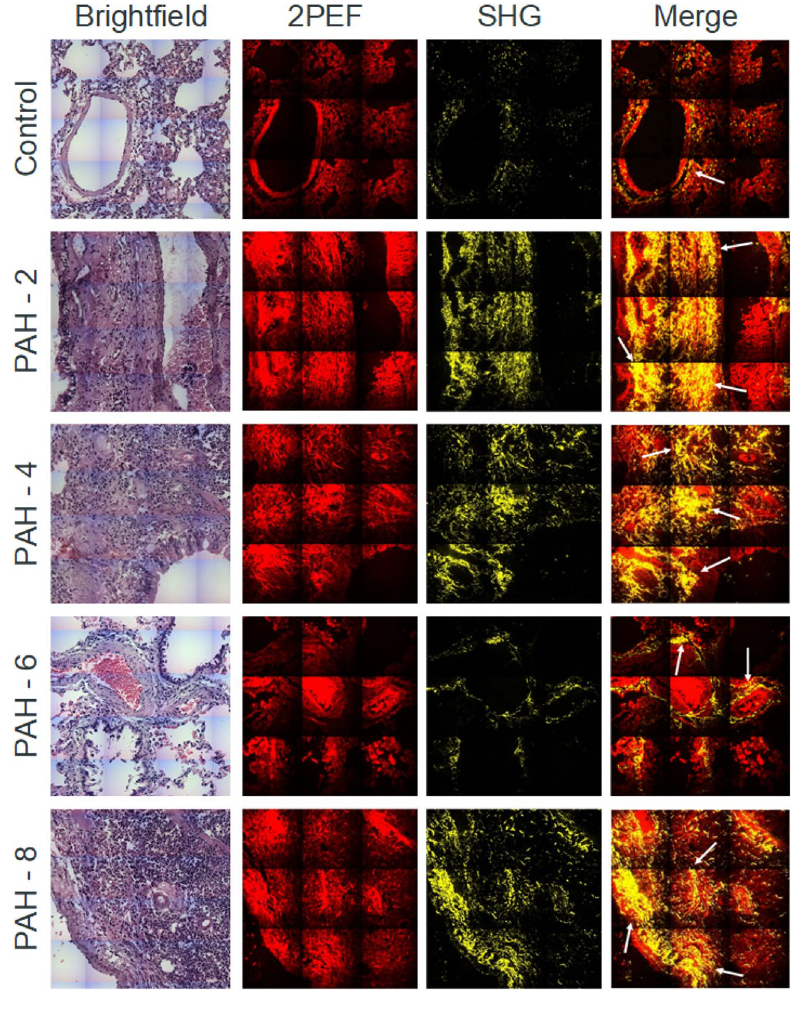
Figure 2. Brightfield images of HE-stained lung tissue, 2PEF, SHG and 2PEF/SHG merged images. Data are presented for lung tissue of control group, and of rats on the 2nd, 4th, 6th, and 8th week of PAH progression. Image size is 450 × 450 µm 2 .